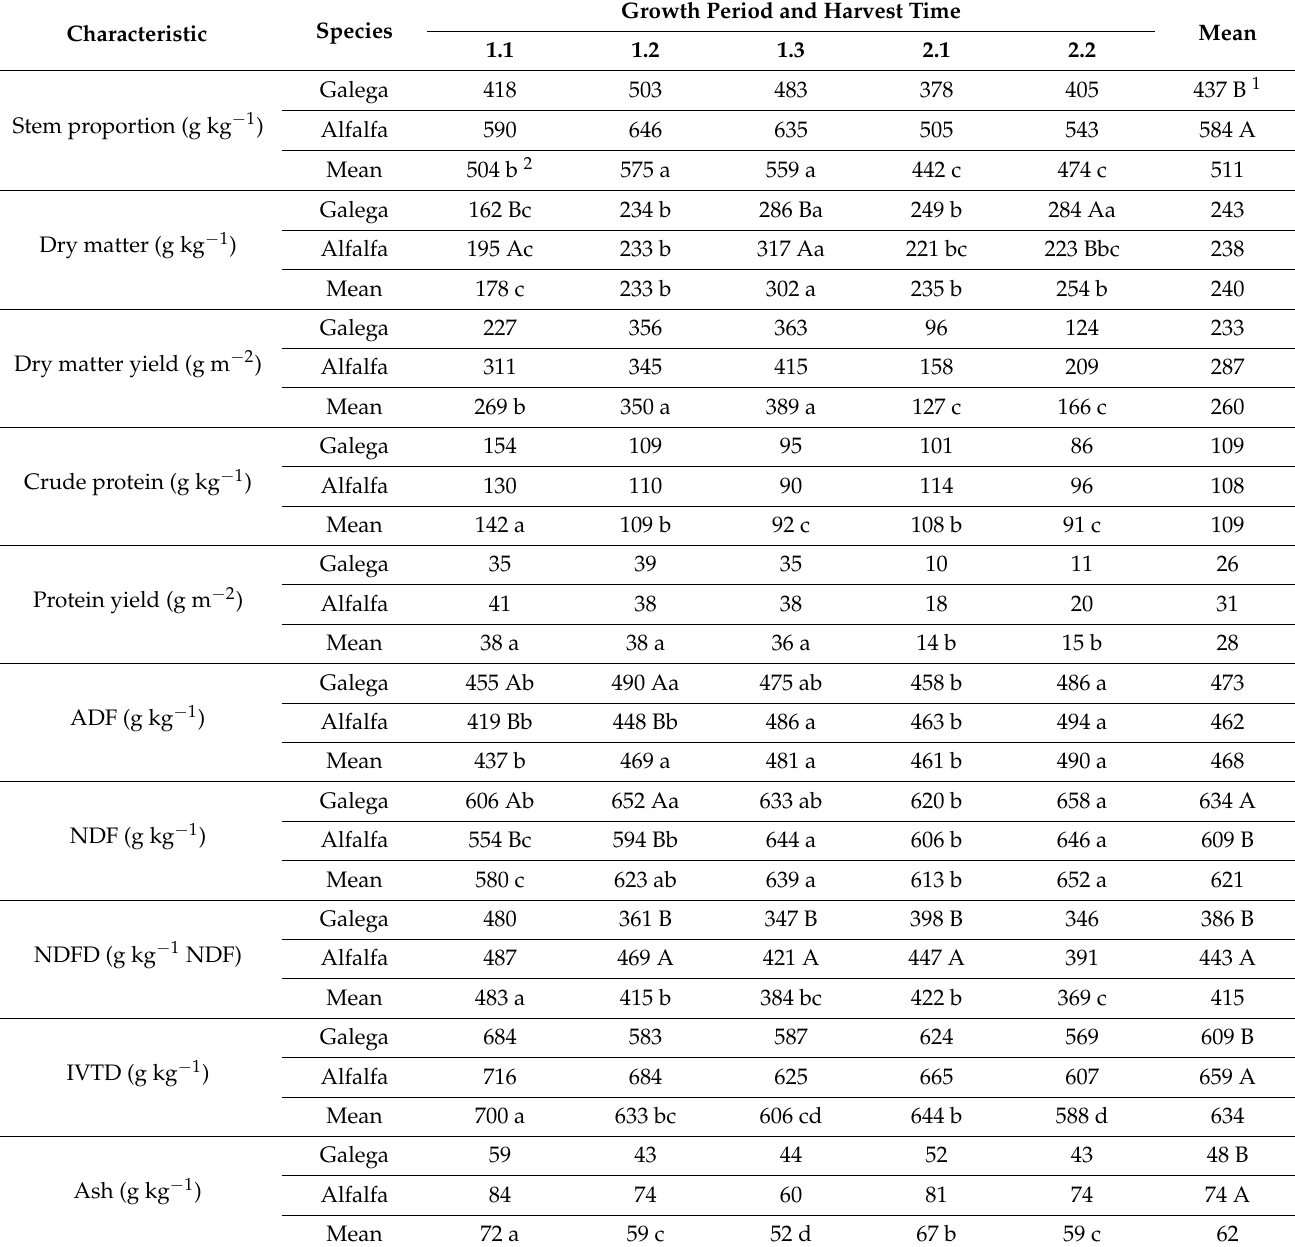
Table 4. Stem proportion, dry matter concentration and yield, crude protein concentration and yield, concentration of ADF, NDF, NDFD, IVTD, and ash in the stems of galega and alfalfa at two growth periods and different harvest times (means over two